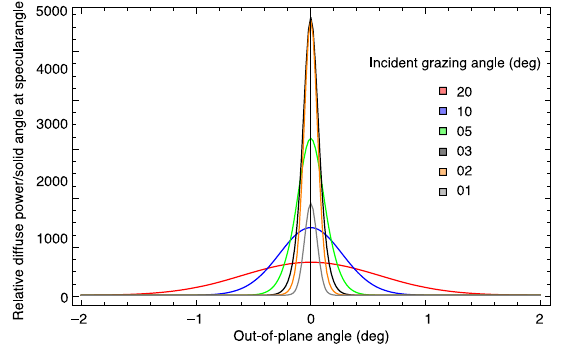
FIG. 4. Out-of-plane diffuse scattering, reflected angle distri- butions for 30 eV photons. The full diffuse scattering expression [Eq. (4)] has been used to calculate these